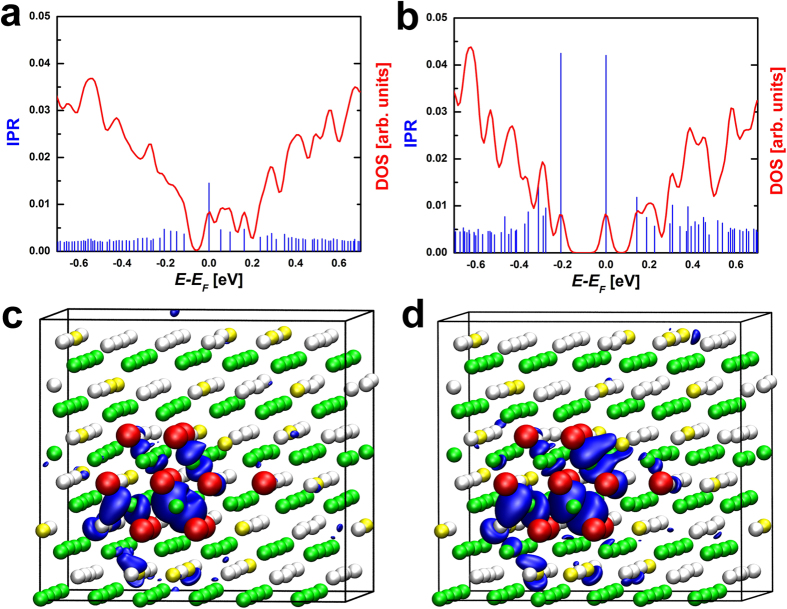
IPR and DOS of a cubic model of Ge9Sb2Te12 calculated (a) with and (b) without SOC.The calculations are carried out using Quantum Espresso49. The corresponding HOMO states are shown in (c) and (d). The isosurfaces render a value of 0.012 a.u.